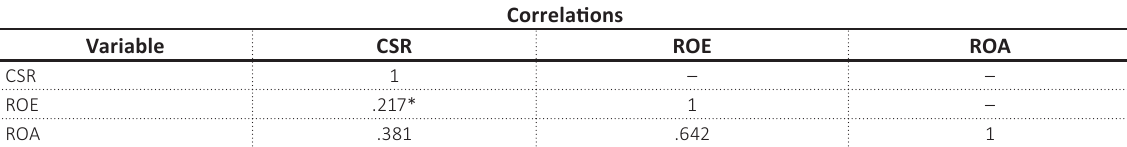
Table 2. Correlation